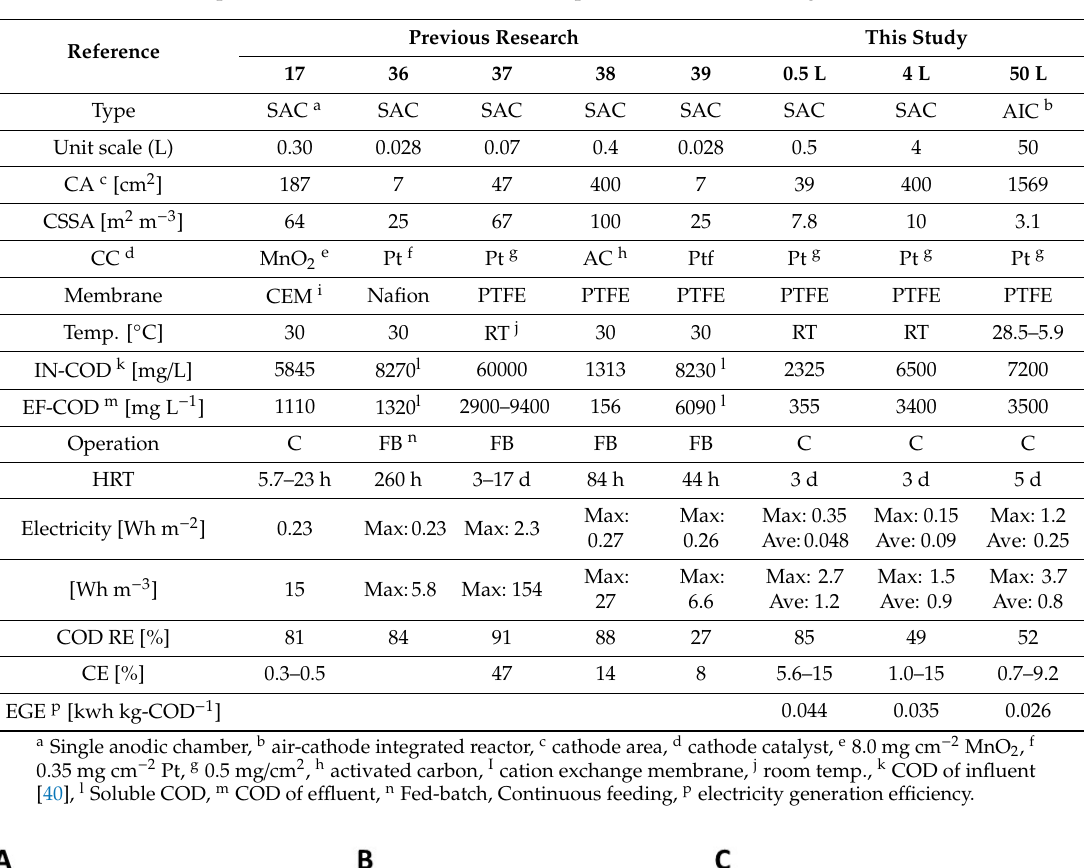
Table 1. A comparison of microbial fuel cell (MFC) performance for treating swine wastewater.